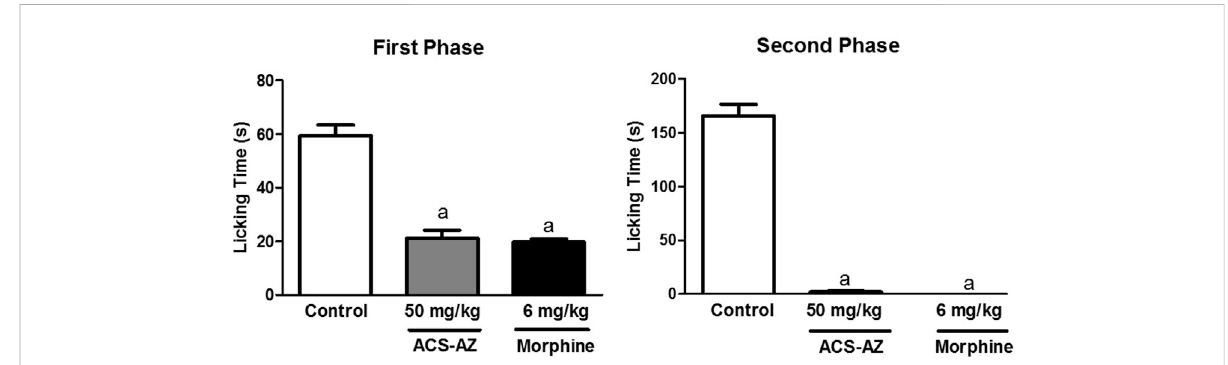
FIGURE 8 Effect of ACS-AZ (50 mg/kg) or morphine (6 mg/kg) pretreatment by intraperitoneal route on the fi rst and second phases of the formalin- induced nociception test. The lick time (seconds) after administration of formalin solution into the mice dorsal surface of the right hind paw was recorded for each animal. The results represent the mean ± SEM ( n = 8) analyzed by one-way ANOVA followed by Tukey test: a p < 0.05 vs. control. ACS-AZ: N ’ -(6-chloro-2-methoxyacridin-9-yl)-2-cyanoacetohydrazide.